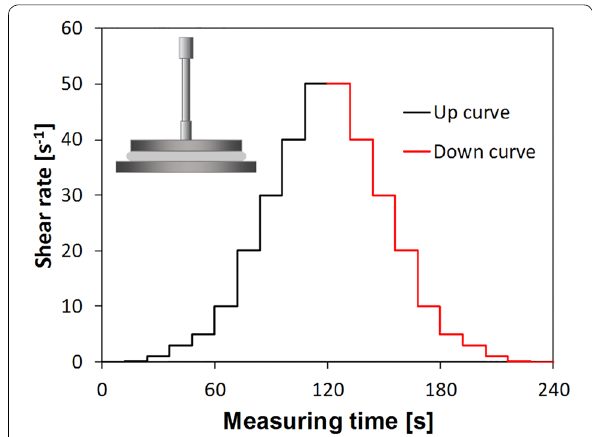
Fig. 2 Applied shear rate with the measuring geometry 35 mm-parallel plates.